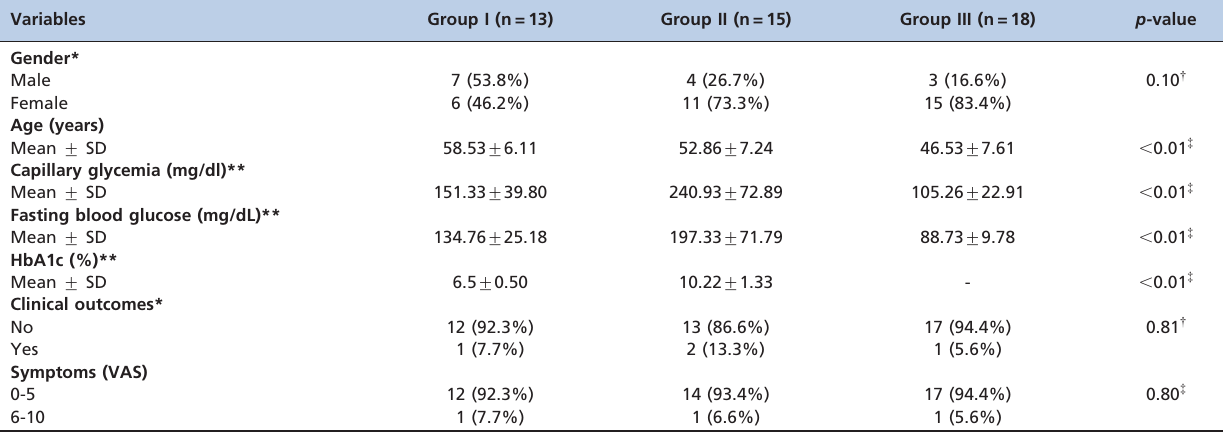
Table 1 - Clinical characteristics of type 2 diabetic patients with adequate (Group I) and inadequate glycemic control (Group II) and non-diabetic subjects (Group III) and the frequency of symptom levels (0-5 and 6-10) reported after dental invasive